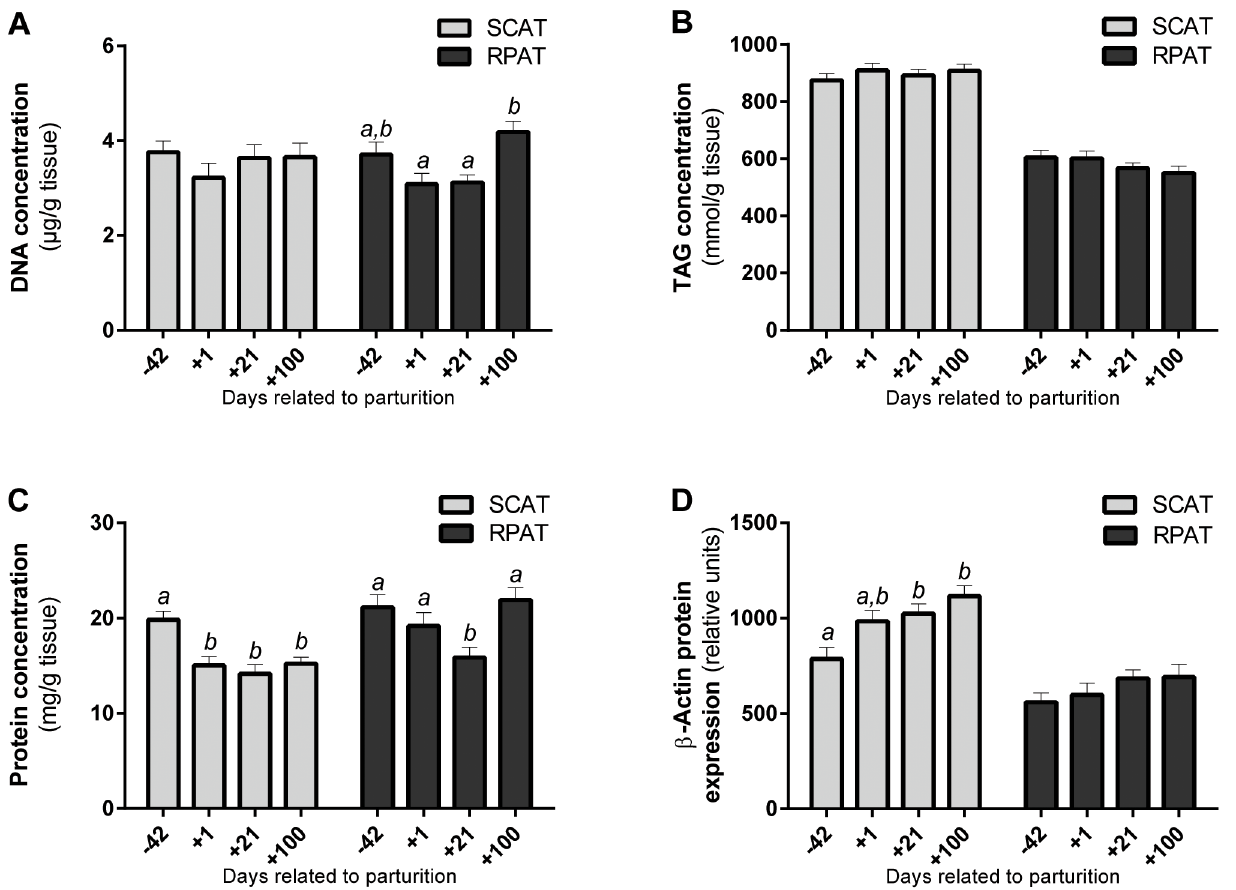
Fig 2. Composition of subcutaneous (SCAT) and retroperitoneal adipose tissue (RPAT) samples of dairy cows around parturition. (A) DNA content, (B) triacylglycerol (TAG) content, (C) total protein content, and (D) β -actin protein expression at 42 days prepartum (d-42), and at 1 day (d+1), 21 days (d +21), and 100 days (d+100) postpartum. Different superscripts indicate P < 0.05. Means ± SEM, n =